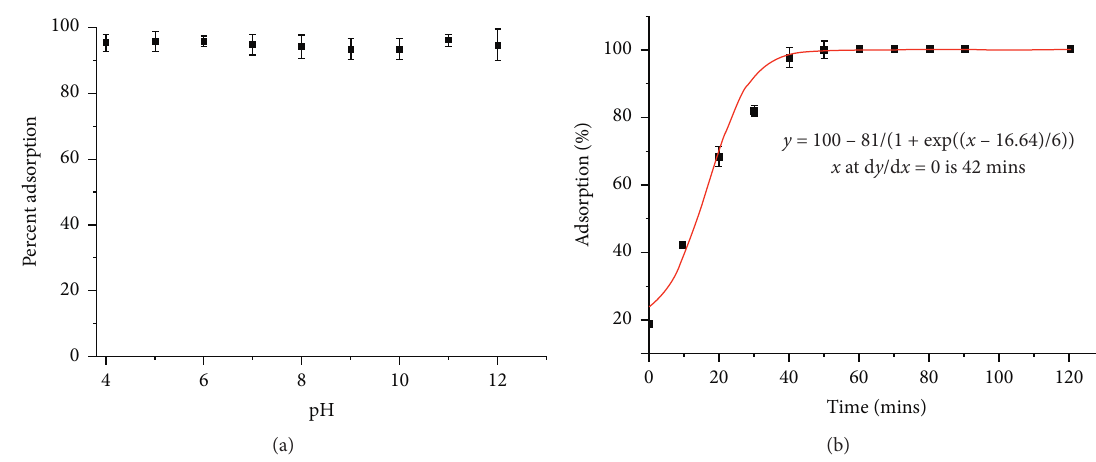
Figure 16: (a) Effect of pH on adsorption of Cr(VI) (100ppm in 50ml) by 0.2 g of Fe 25 ° C; (b) effect of time on adsorption of Cr(VI) (100ppm in 50 ml) by 0.2 g of Fe 3 O 4 @SiO 2 @LEuH@PW 10 nanocomposite; T � 25 °